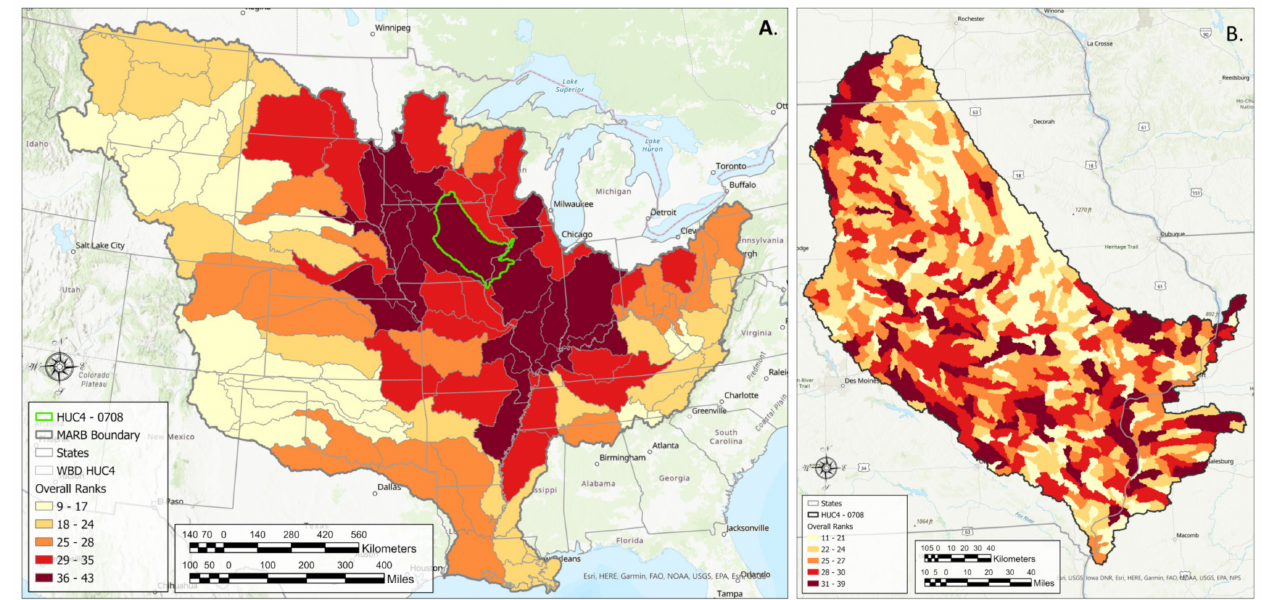
Figure 6. Combined quantile ranking of flood and nitrate risks with total NI practices at the HUC4 scale ( A ) and in the Iowa-Cedar basin ( B